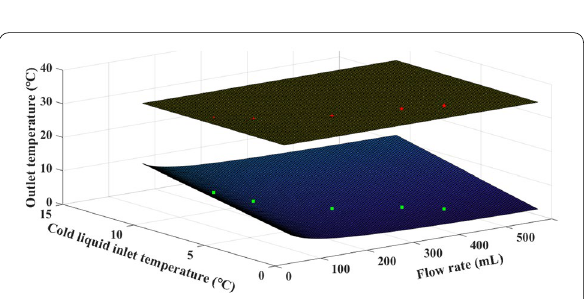
Figure 8 Comparison of output temperature trend curves influenced by input flow and temperature during